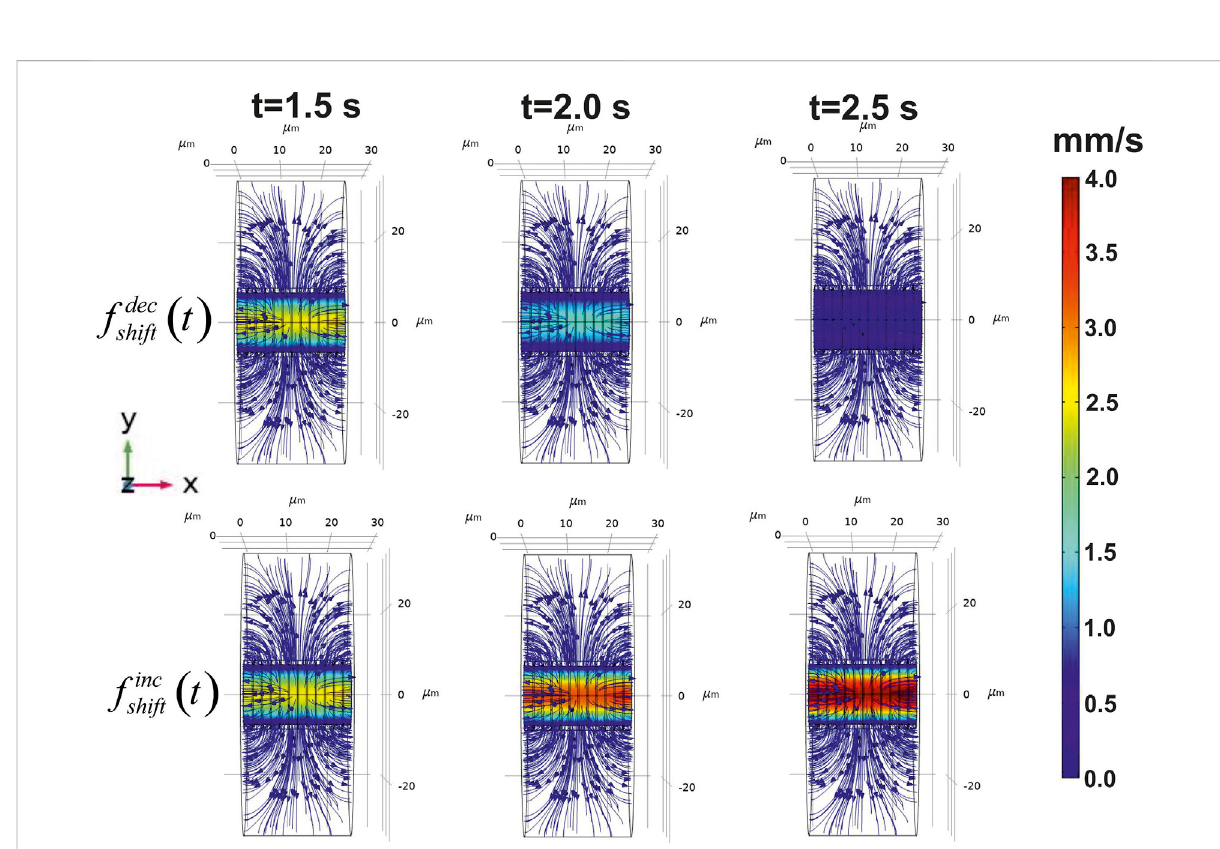
FIGURE 4 Calculatedvelocity fi eldinthevirtualphantom.Theblood fl owvelocitiesandISF fl owarerepresentedinthethreepointsoftheconsideredtime area. The distribution of the velocities is shown on the central longitudinal cut plain XY. The application of the step-like function to the pressure causes either decreaseofCBF ( f dec shift ( t ) ,upperset) orincrease ofCBF( f inc shift ( t ) , lowerset).Thearrowsindicatethedirection ofcalculated velocity fi elds in